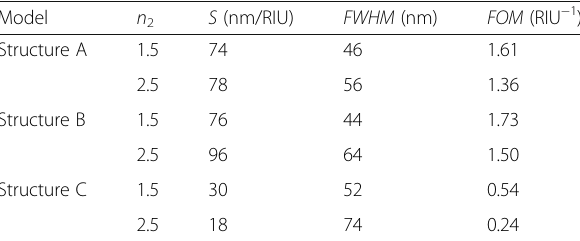
Table 2 Scattering peak wavelengths, performance parameters S and FOM of structure A to C calculated from Fig. 3 Model